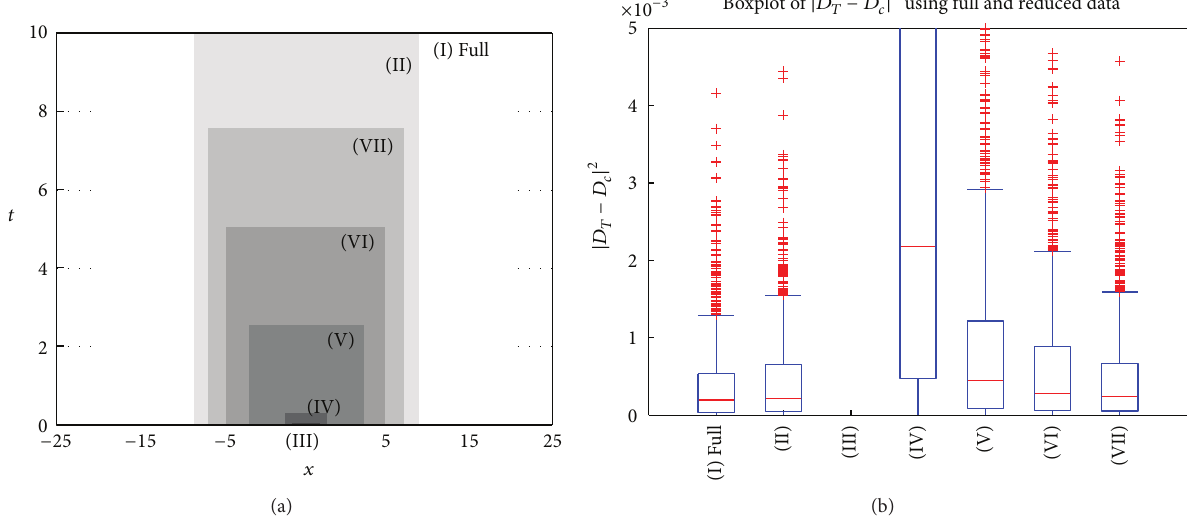
Figure 3: Comparison of the squared error |𝐷 𝑇 − 𝐷 𝑐 | 2 for 7 rectangular spatiotemporal regions. (a) Data regions for the cases (I)–(VII); full data are represented by the white region [− 25 , 25 ]×[ 0 , 10 ] , case (I). Reduced data, in cases (II)–(VII), are indicated by different shadings. (b) Boxplot of the error |𝐷 𝑇 − 𝐷 𝑐 | 2 corresponding to the use of data from the respective